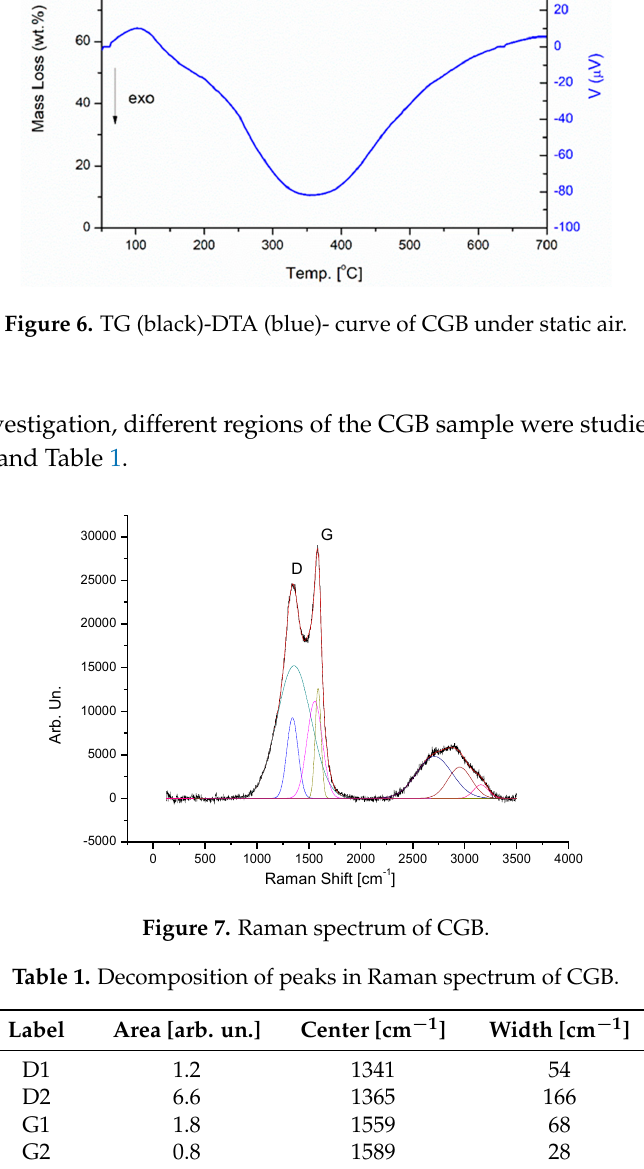
Figure 6. TG (black)-DTA (blue)- curve of CGB under static air.